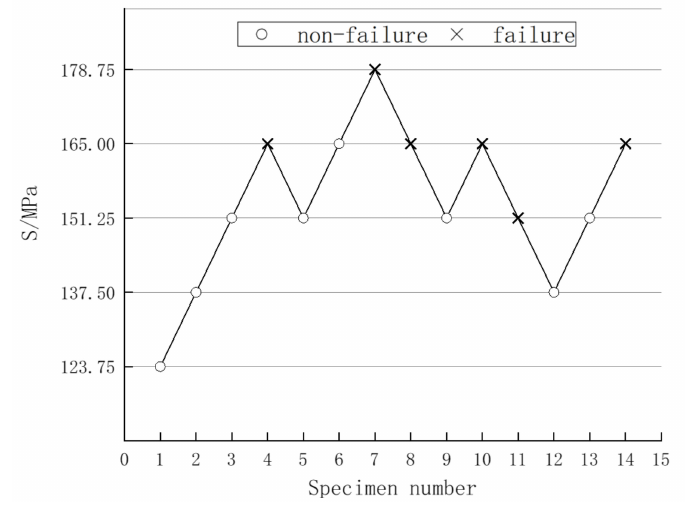
Figure 13. Up-and-down diagram of Q355 notched specimen.